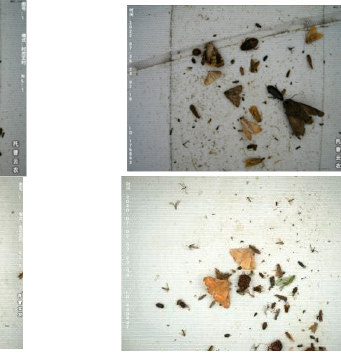
Figure 1. Part of the original